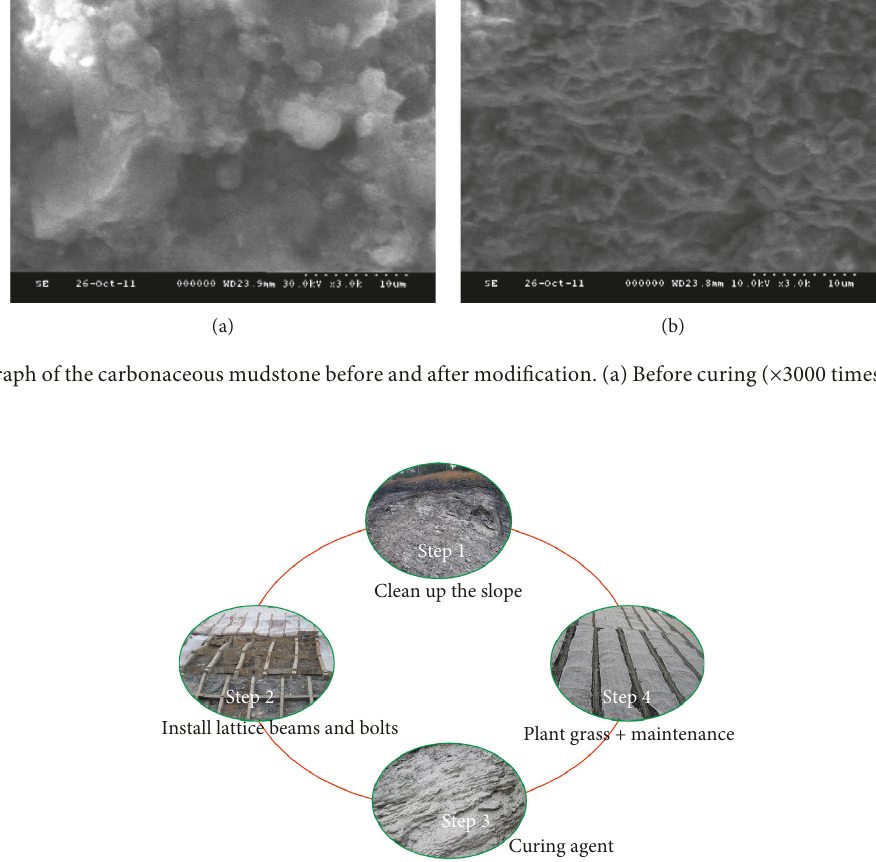
Figure 12: Construction technology process.